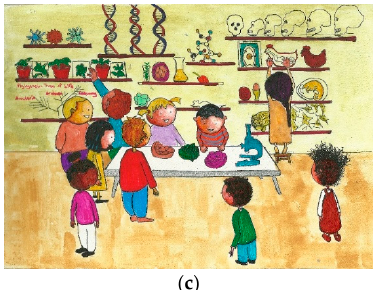
Figure 8. Clockwise: ( a ) Before the travel starts: learners prepare for the adventure trying on their equipment; ( b ) the adventure; and ( c ) back in the curiosity cabinet (design: Christoforakis and Chrysoglou).